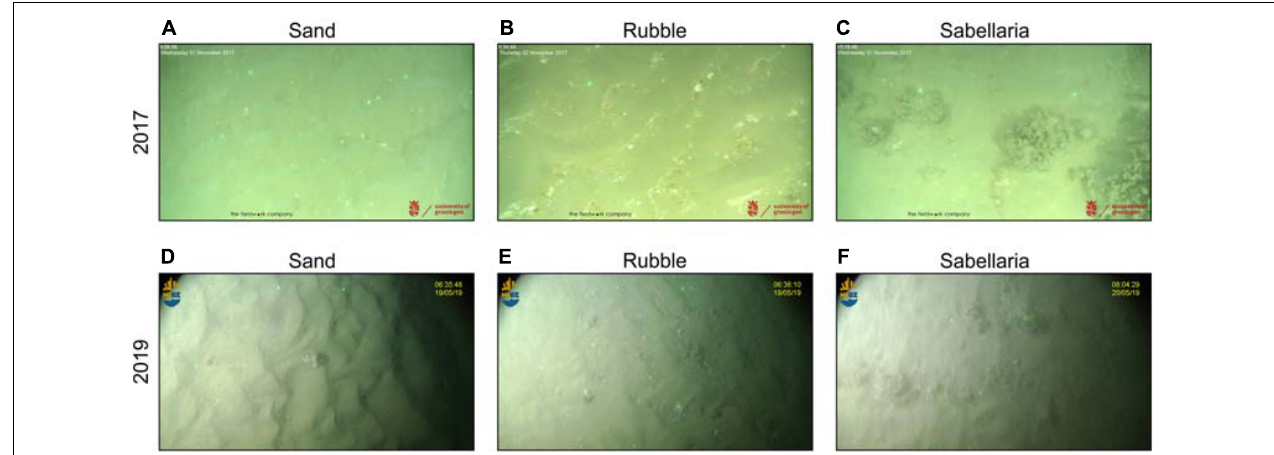
FIGURE 3 | Habitat types observed in video transects. (A) sand habitat in 2017. (B) rubble habitat in 2017. (C) sabellaria habitat in 2017, with several S. spinulosa reef fragments, two starfish ( Asterias rubens ) and a dragonet (Callionymidae). (D) sand habitat in 2019, showing a hermit crab ( Pagurus bernhardus ). (E) rubble habitat in 2019. (F) sabellaria habitat in 2019, showing several S. spinulosa reef fragments, and three starfish ( A. rubens ). Green dots are lasers, set to a distance of 35 cm and 30 cm for 2017 (A–C) and 2019 (D–F) , respectively.